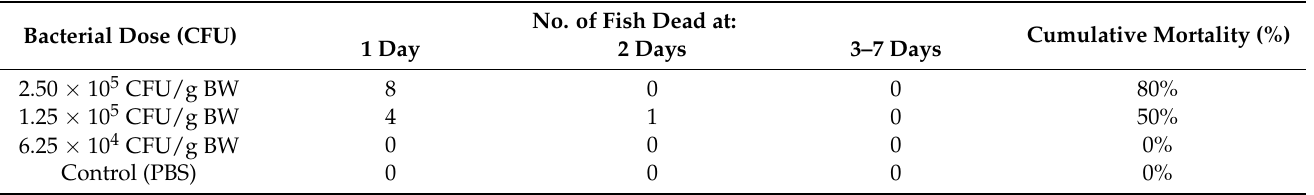
Table 4. Mortality of juvenile Oplegnathus punctatus challenged with the Vibrio harveyi isolate via intraperitoneal injection.